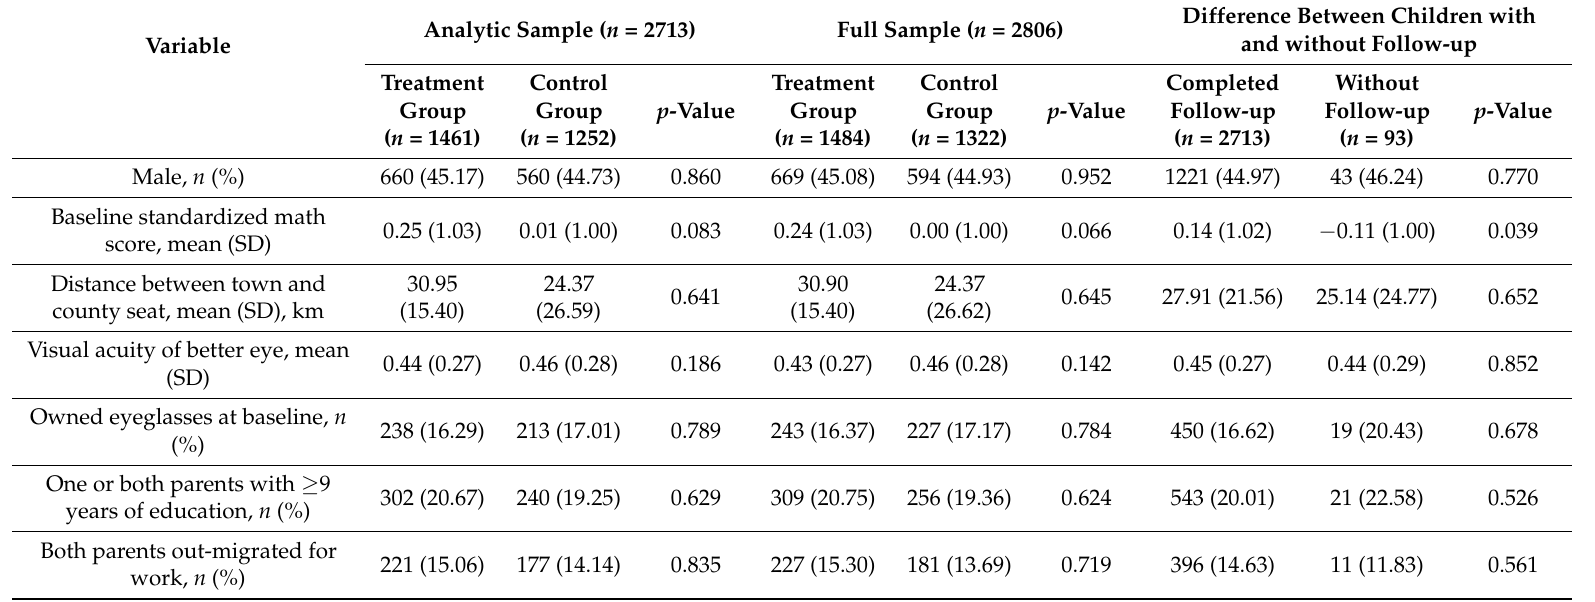
Table 1. Baseline characteristics of children with correctable refractive error, by group assignment.